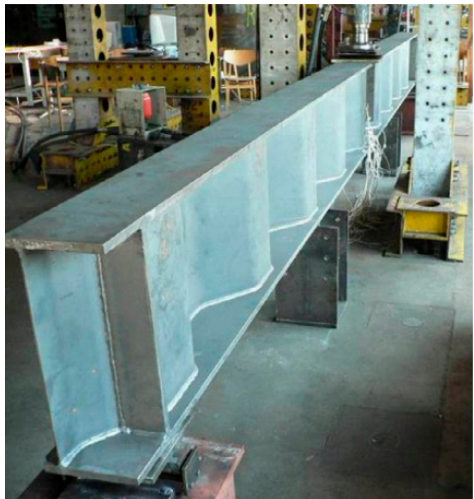
Figure 2. Loading under three-point-bending, reproduced from [38], with permission of Elsevier 2014.